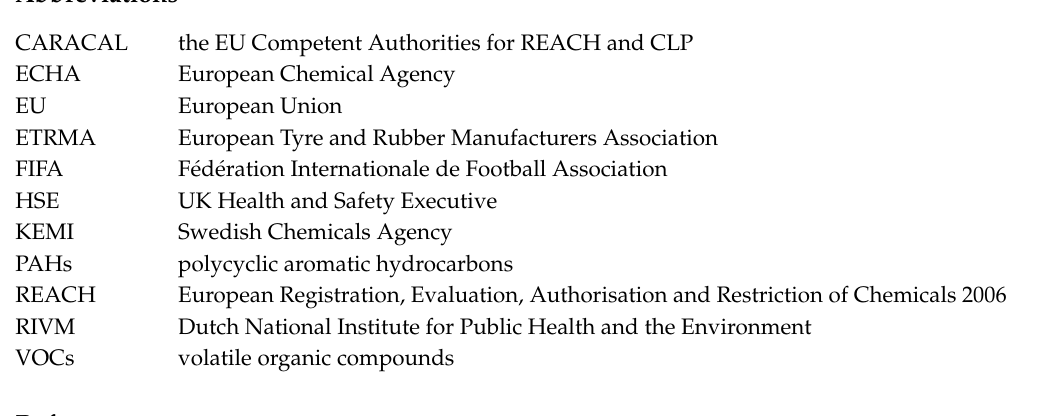
Table S1: CRUMB Rubber Data Sheets Table—A Google search on June 10th produced about 12,400 references to crumb rubber MSDS without inverted commas. With inverted commas, it produced 215 results but not all related to specific MSDSs or for artificial turf and play surfaces, Table S2: HSE visits to crumb rubber/rubber granulate and artificial turf manufacturers & suppliers between 1 April 2005 and 31 March 2015. Conflicts of Interest: The authors declare no conflict of